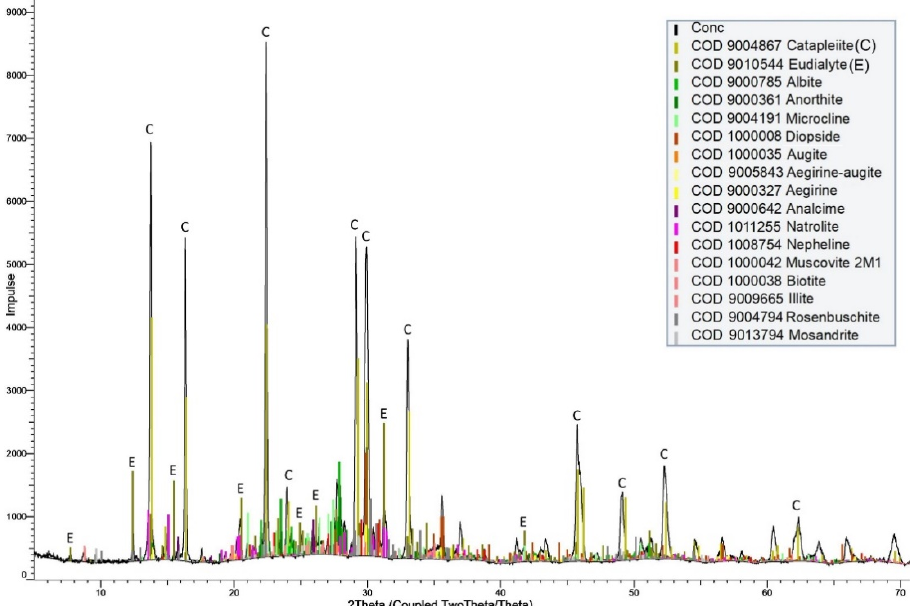
Figure 10. Distribution of individual rare earth elements in Zr-REE-bearing concentrate.